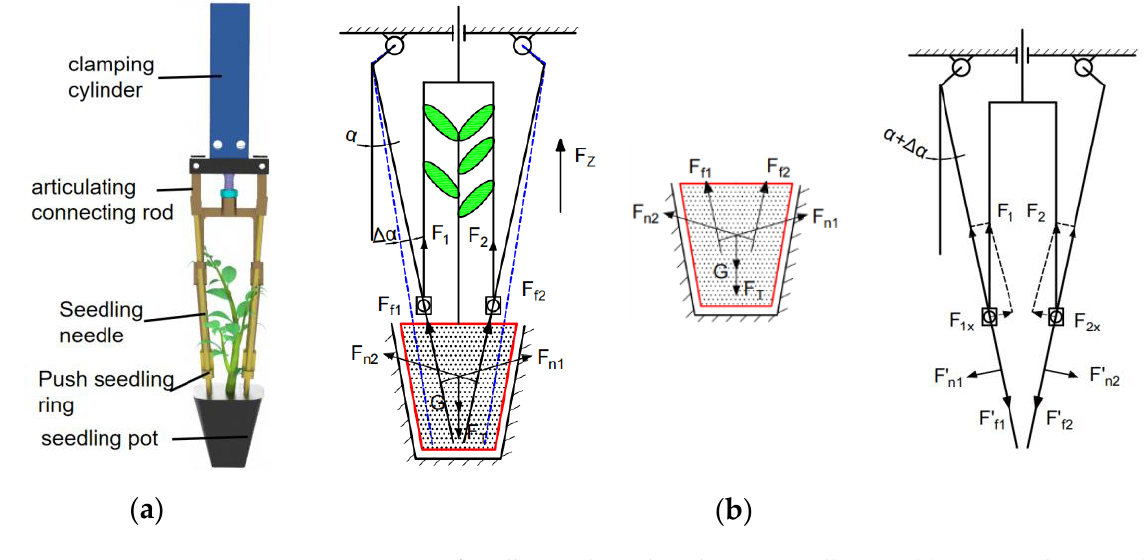
Figure 4. Diagram of seedling-picking claw clamping seedling pot:( a ) structure diagram of seedling-picking claw; ( b ) stress analysis diagram of seedling-picking claw and pot body.